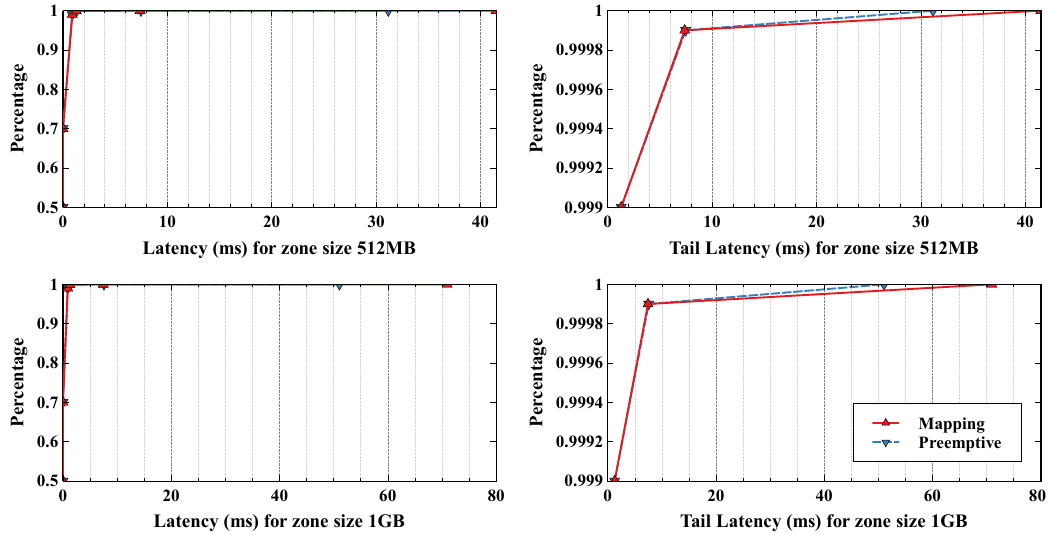
Figure 8. RocksDB write latency of fillrandom with 464B